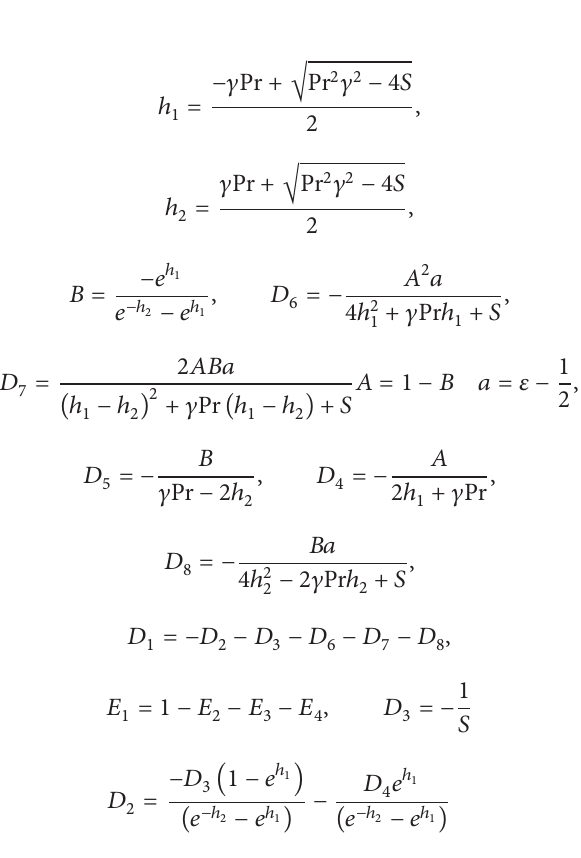
the Sherwood number. It is noted that as time increases, the Sherwood number also increases until a steady state is attained. It is also evident from this figure that higher values of 𝛾 reduce